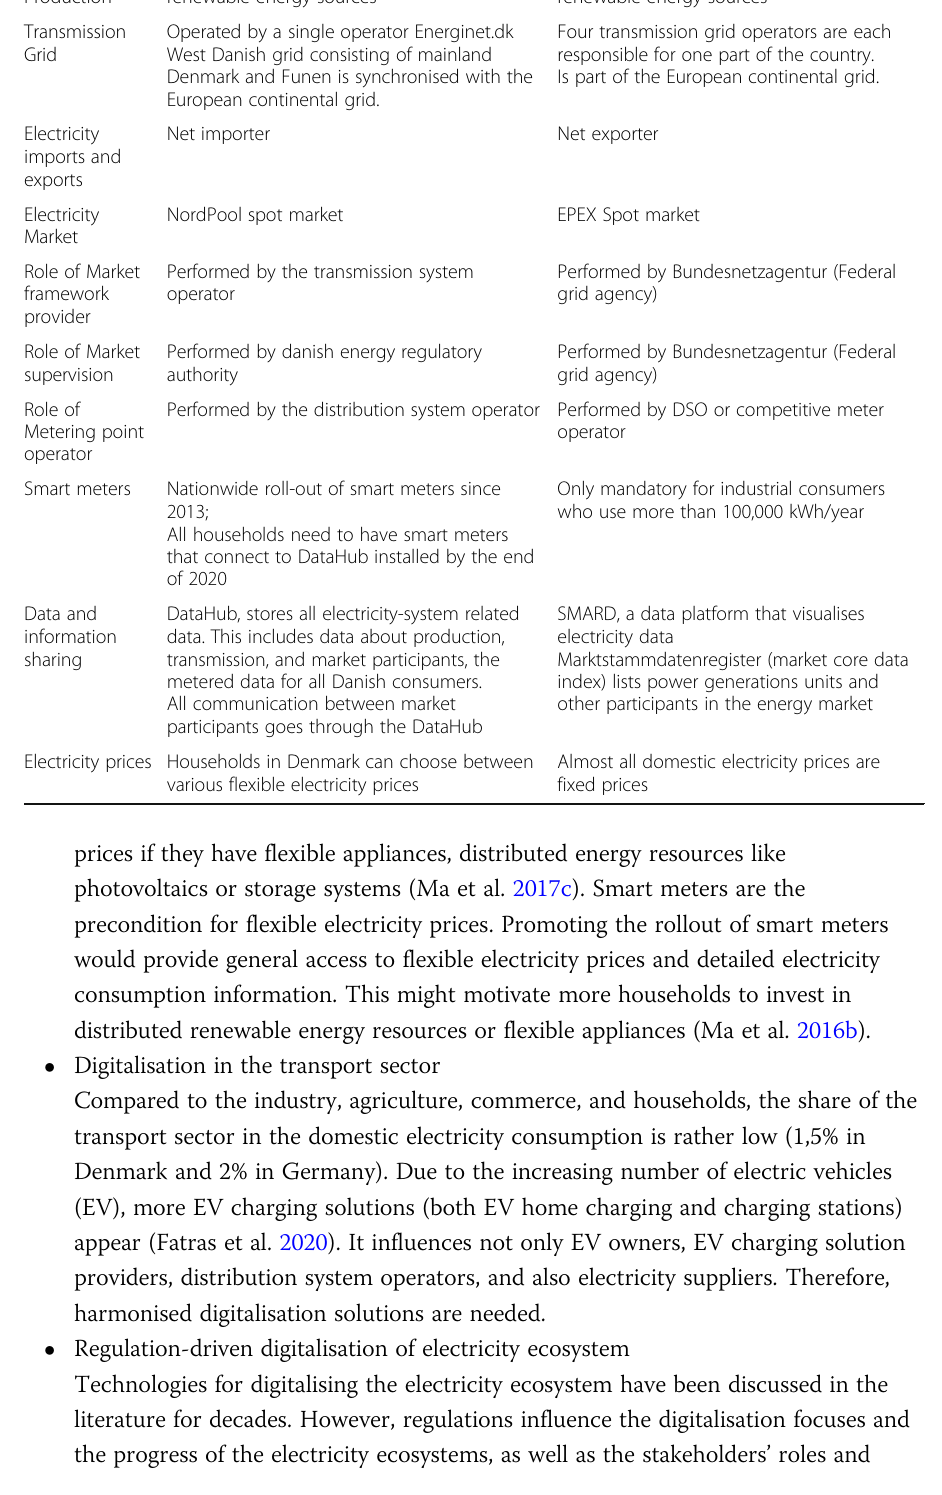
Table 5 Summary of differences in electricity ecosystem between Denmark and Germany Differences in Denmark Germany electricity ecosystem Electricity Production Transmission